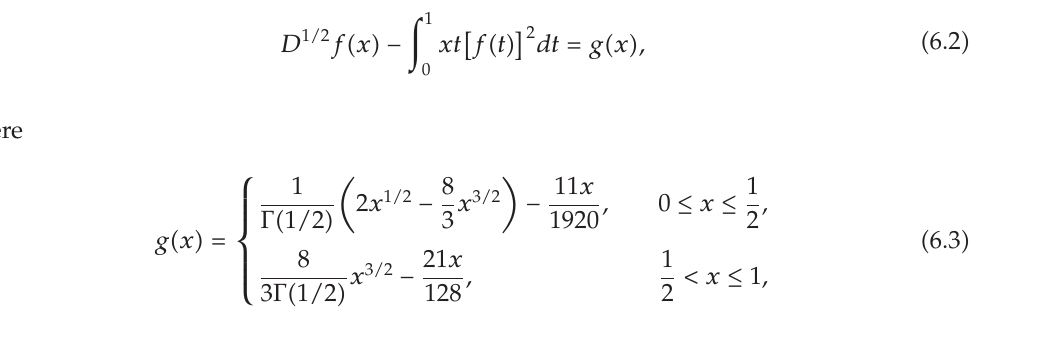
The numerical results for M (cid:8) 1 , N (cid:8) 2 , and α (cid:8) 1 / 4 , 1 / 2 , 3 / 4, and 1 are plotted in Figure 1. For α (cid:8) 1, the exact solution is given as f (cid:6) x (cid:7) (cid:8) x . Note that, as α approaches 1, the numerical solution converges the analytical solution f (cid:6) x (cid:7) (cid:8) x